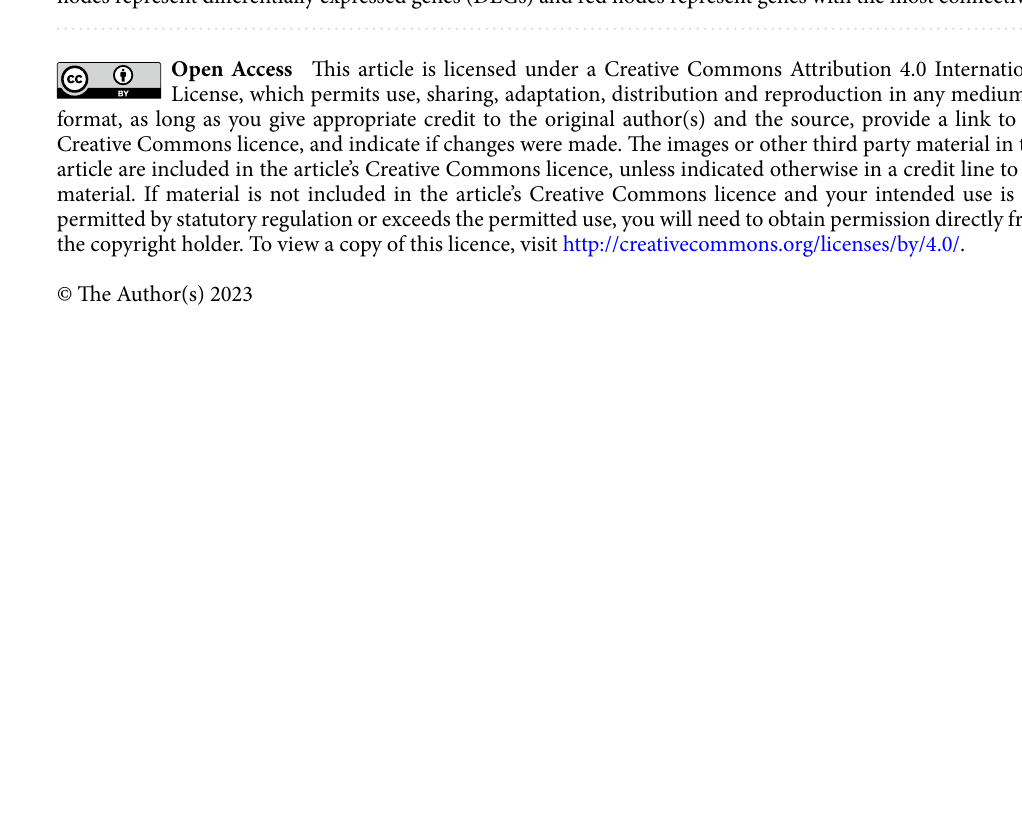
Figure 5. Differential co-expression network constructed using DiffCorr algorithm. Each node is a gene, violet nodes represent differentially expressed genes (DEGs) and red nodes represent genes with the most